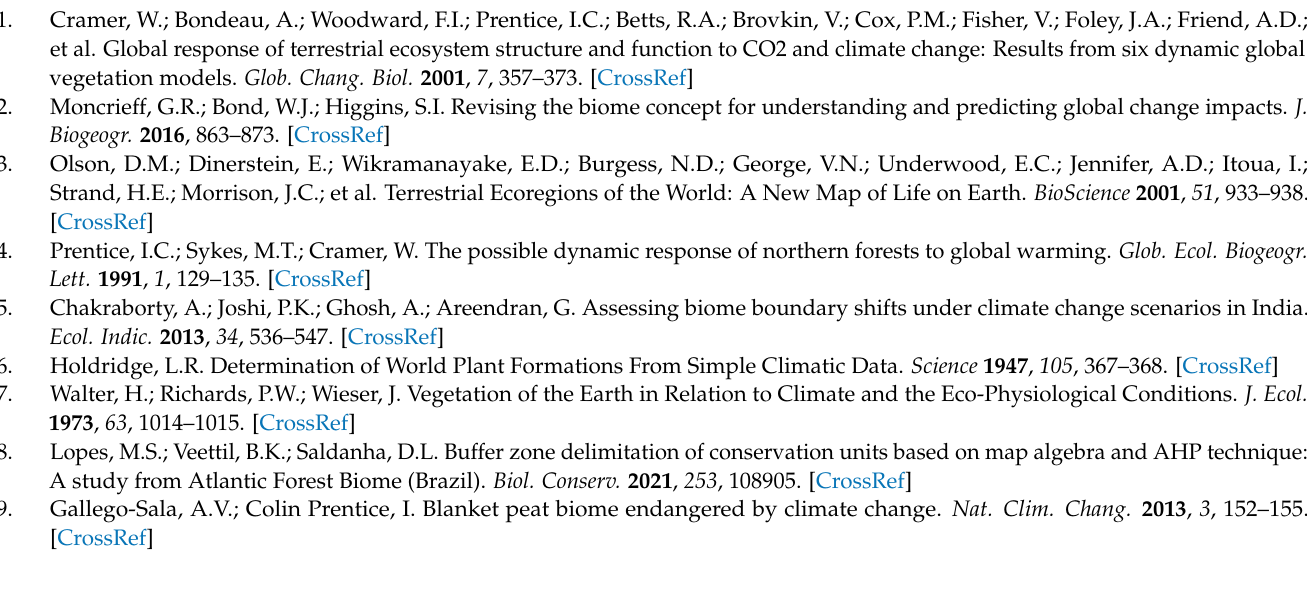
Figure A3. Confusion matrix of biomes with RF constructed with the test data (20% of the observed map). The rows represent the biomes of the present map, while the columns represent the biomes classified by RF. Recall metric is displayed on the matrix. The color bar indicates the number of pixels used to in each category.